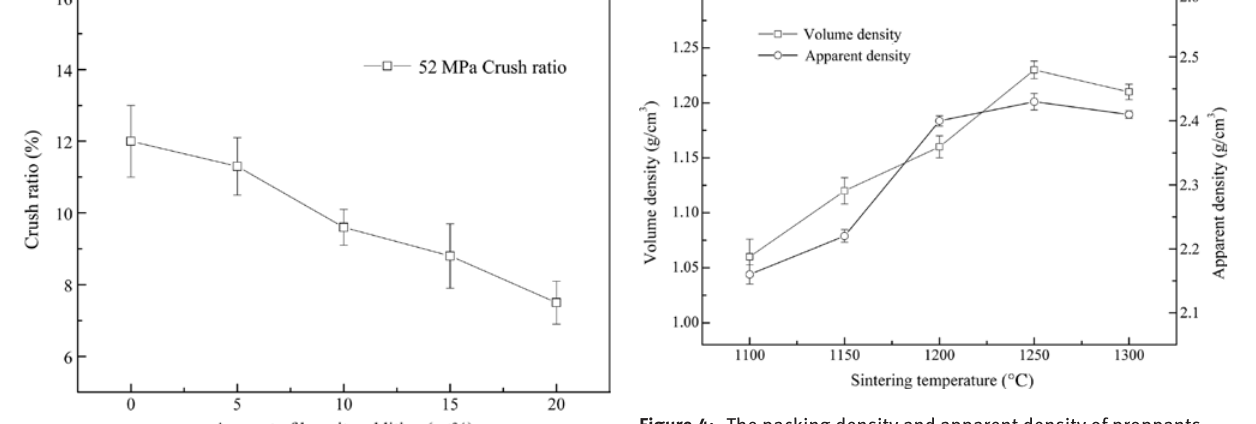
Figure 4: The packing density and apparent density of proppants sintered at different temperatures.